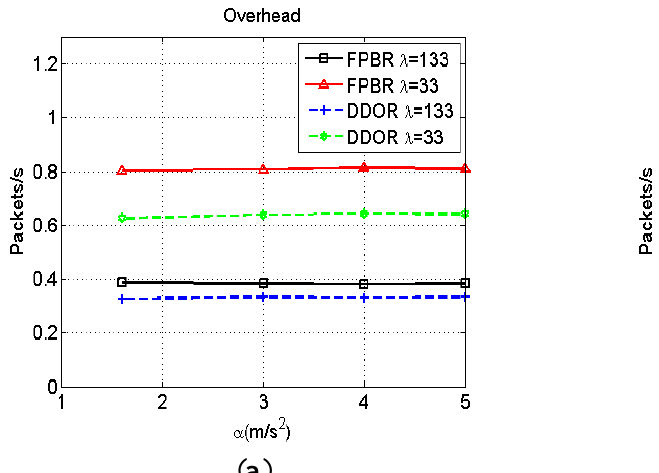
Figure 9. Network and MAC overhead obtained with FPBR and DDOR when increasing the maximum acceleration, . Two different vehicle densities were considered for these plots: λ = 133 and λ = 33. ( a ) Network overhead vs.α . ( b ) MAC overhead vs. α